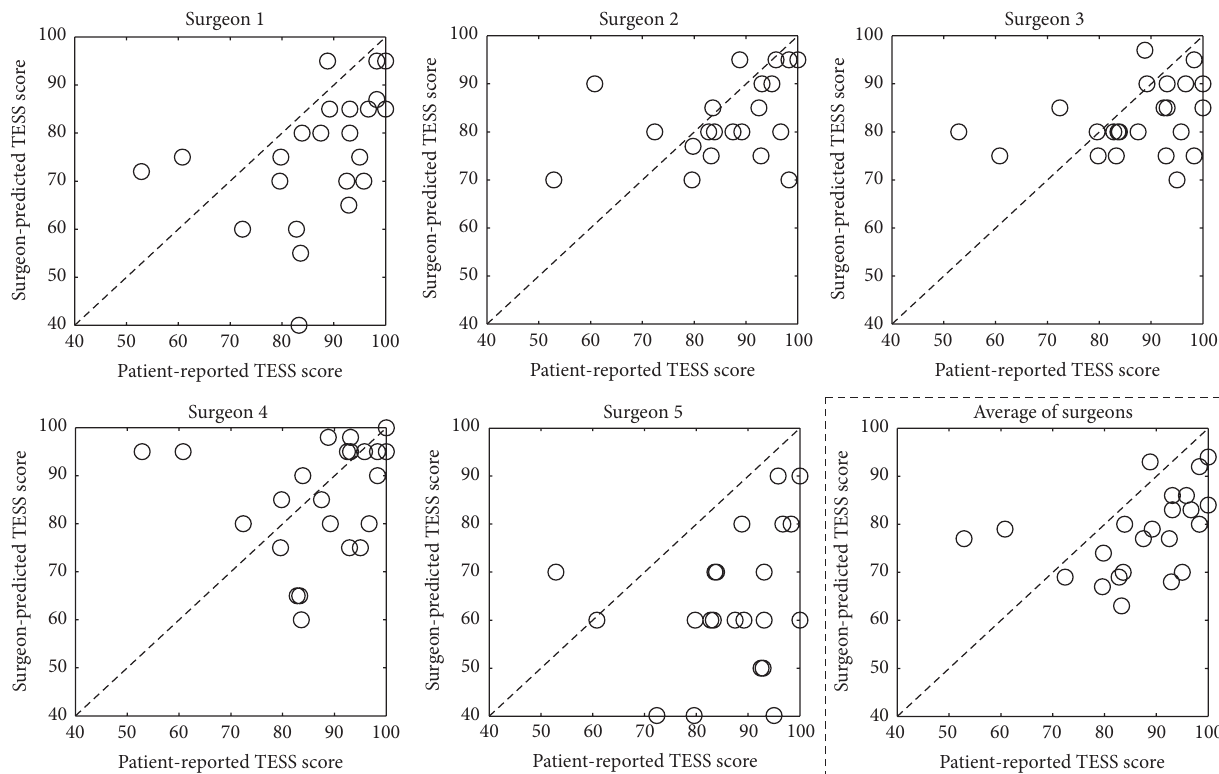
Figure 3: Scatter plots of patient-reported outcome and orthopedic tumor surgeon predictions on the Toronto Extremity Salvage Scale (TESS). The dashed lines indicate a hypothetical perfect correlation; if a patient case lies above or below this line, the functional outcome was overestimated or underestimated, respectively.